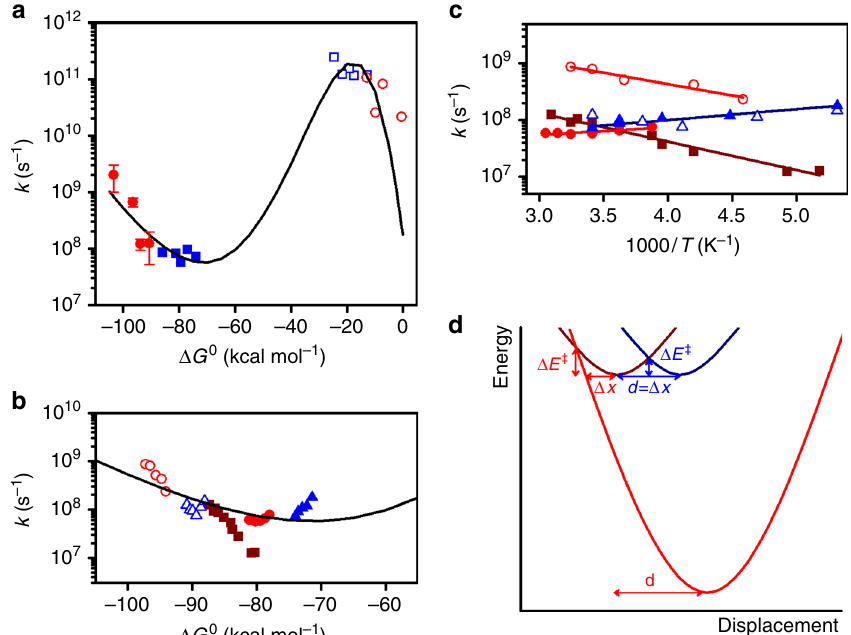
Fig. 5 Driving force and temperature dependencies of electron transfer rates. a Charge separation (open symbols) and charge recombination (closed symbols) in 1 (squares) and 2 (circles) as a function of the driving force at T = 293 K. Points with error bar present average value and sample standard deviation of three to six independent measurements. b Charge recombination as a function of the driving force for all temperatures: 1/DCM (full triangles), 1/CHF (full circles), 1/NBE (full squares), 2/DCM (open triangles) and 2/CHF (open circles); the driving forces were estimated at each temperature using the dielectric constant at that temperature, interpolated from the available dielectric constants (Supplementary Table S2). c Temperature dependence of the charge recombinations; symbols as in b . d ET coordinate using a single averaged mode approximation illustrating the tunneling barrier width ( Δ x ) and height ( Δ E ‡ ), and the increase of d with Δ G 0 given by